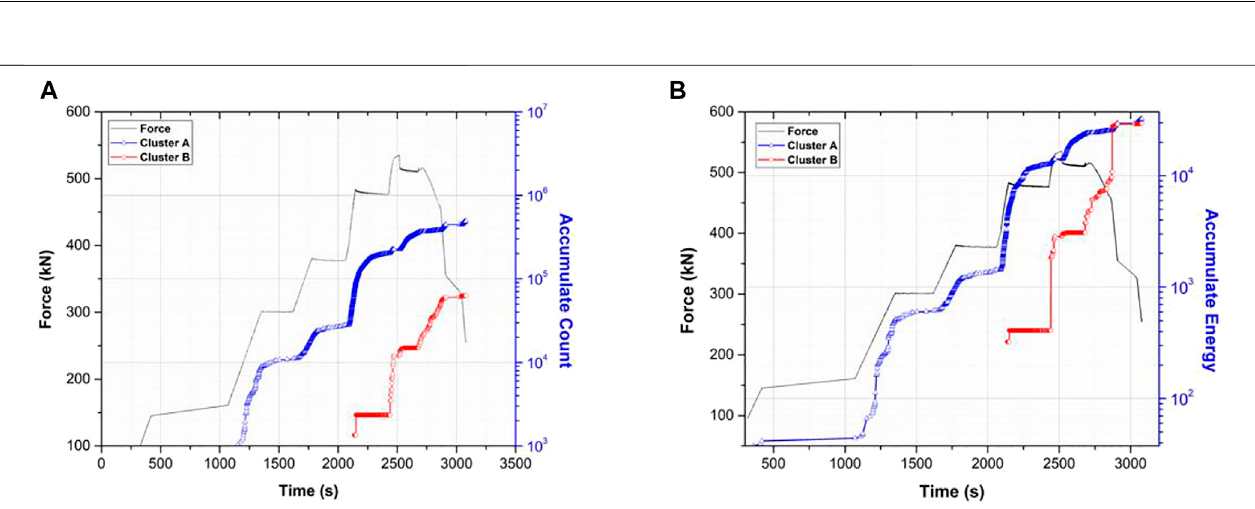
FIGURE 8 | Accumulate counts (A) and accumulate energies (B) of two clusters of AE signals corresponding to two cracking modes over entire loading path.